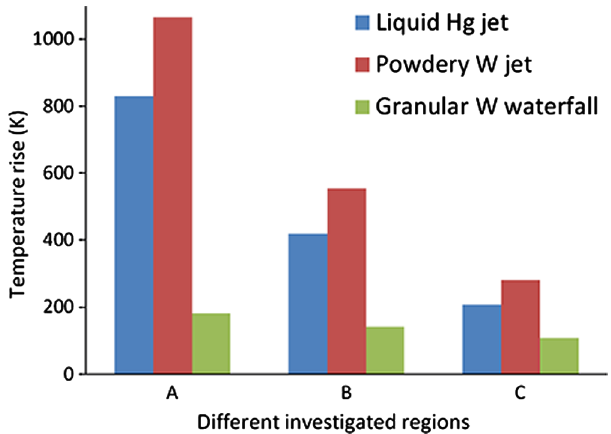
FIG. 4. Temperature rises in different regions (within beam profiles) for the three